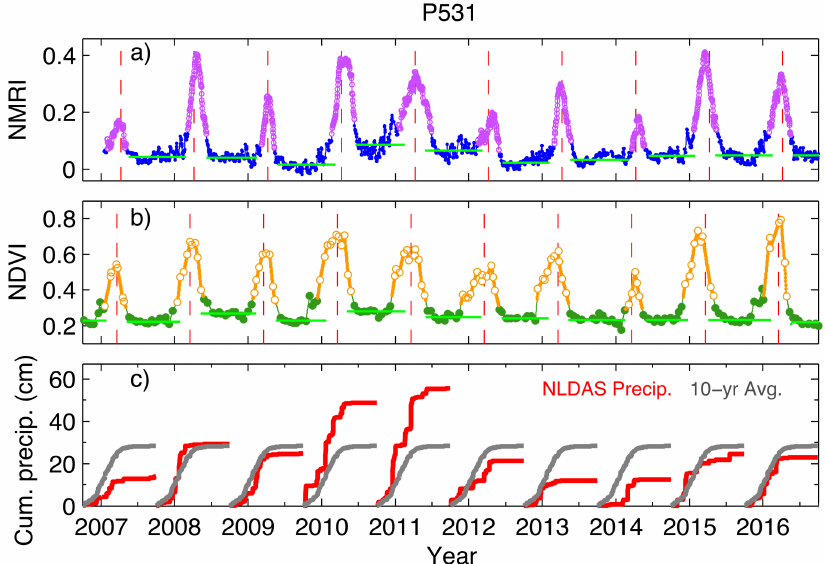
Figure 2. Time series for GPS site P531: ( a ) NMRI time series after application of a five-day centered median filter; ( b ) Normalized Difference Vegetation Index (NDVI) data including linear interpolation between observed values. ( a , b ) data analysis: Green horizontal lines show the baseline level for amplitude calculation, determined separately between peaks. The lavender (yellow) circles for NMRI (NDVI) show the interval above the 25% cut-off around the main seasonal peak. The red vertical dashed line is the Mean Peak day of year. ( c ) North American Land Data Assimilation System (NLDAS) cumulative precipitation for each Water Year (red), and the 10-year average (gray). P531 is a grasslands site with an annual precipitation of 428 mm at latitude/longitude of N 35.8 ◦ and W 120.54 ◦